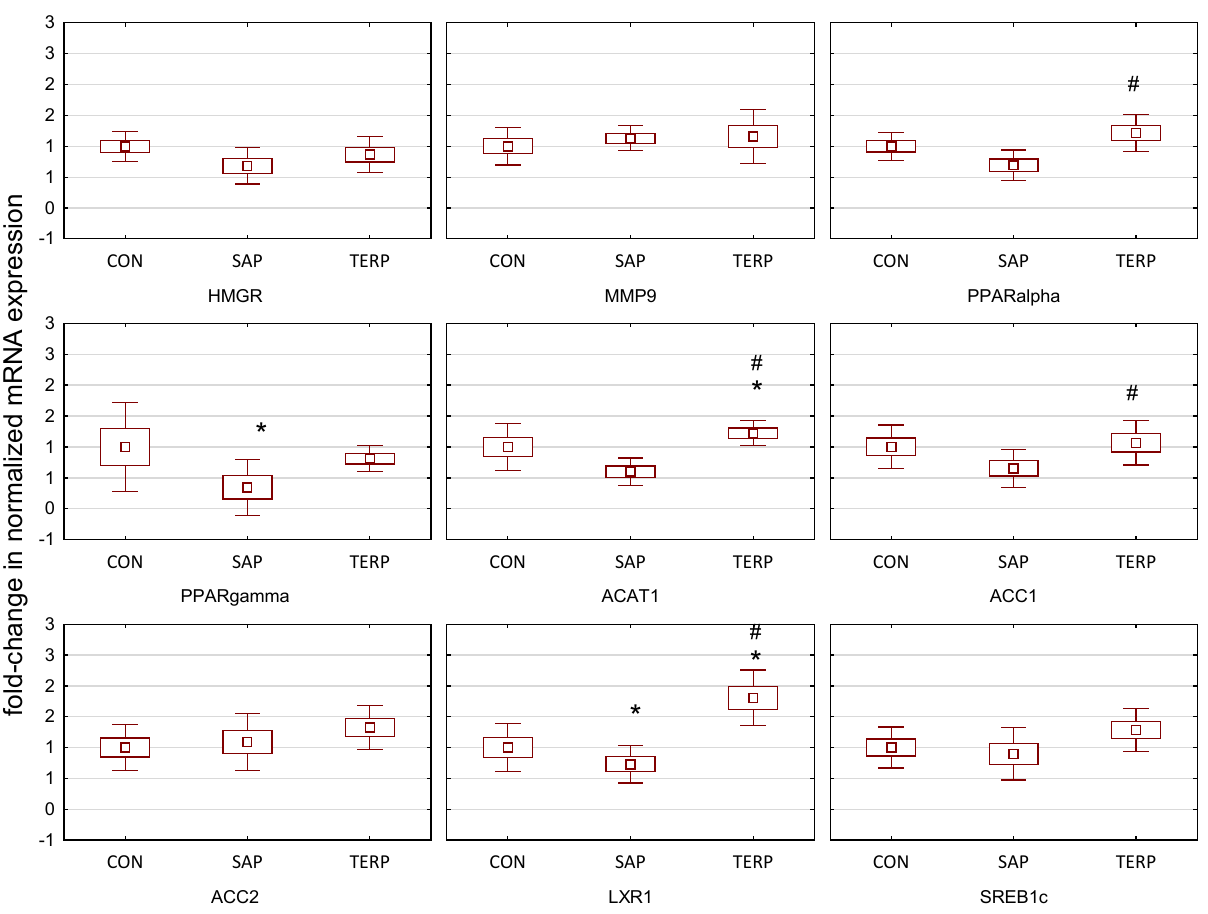
Figure 3. Expression of genes after treatment of saponin and terpenoid fraction in Zucker rat liver. CON, control group; SAP, rats fed a standard diet with the addition of saponin fraction; TERP, rats fed a standard diet with the addition of terpenoid fraction. Values were normalized against Gapdh expression and presented as a fold-change in relation to gene expression in a control group. Specific comparisons: * p < 0.05 vs . CON; # p < 0.05 vs . SAP (ANOVA followed by the post hoc test). HMGR , 3-hydroxy-3-methyl-glutaryl-coenzyme A reductase; MMP 9, matrix metallopeptidase 9; PPARalpha